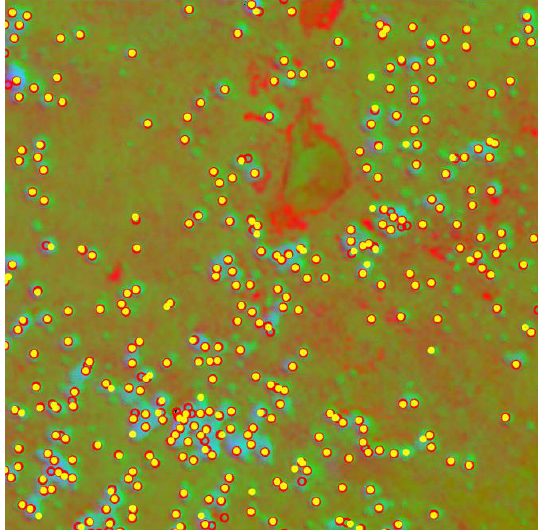
Figure 9. The treetop detection result of the prairie area. The yellow dots are the treetops detected by FCN and the red circles are the treetops detected by THR